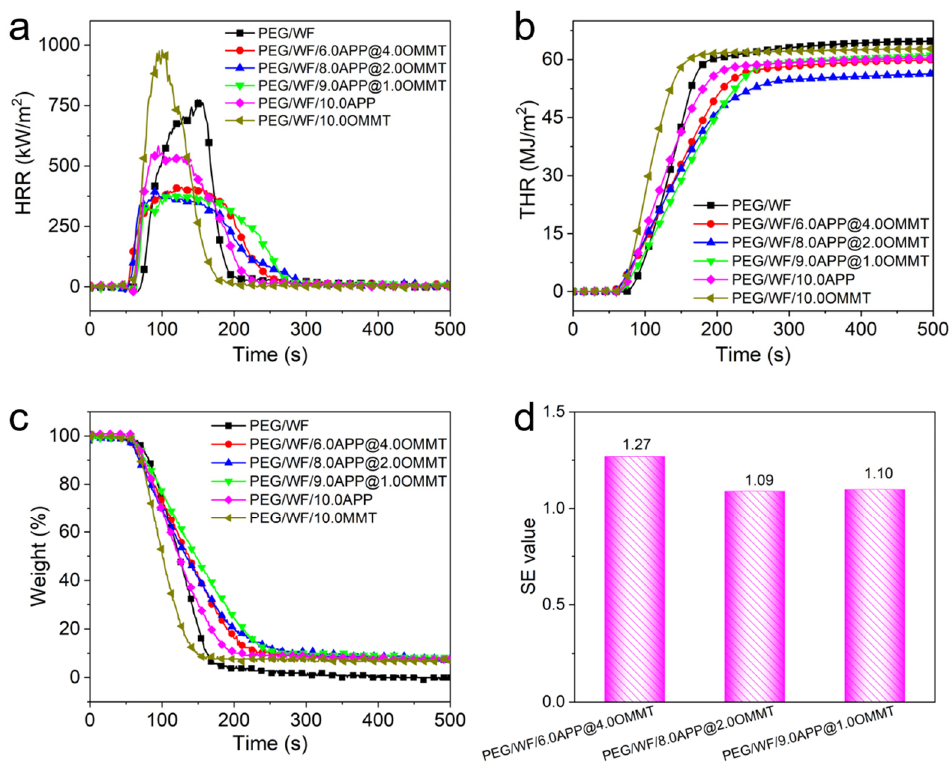
Figure 2. ( a ) HRR, ( b ) THR, ( c ) weight, and ( d ) SE values of PEG/WF and its composites obtained from cone calorimetry. Table 1. Cone calorimetric data for PEG/WF and its composites (heat flux of 35 kW/m 2 ). Sample No.